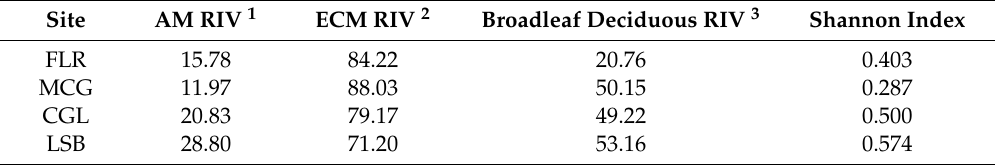
Table A1. Tree stand composition of the four field sites. Data from Smith et al.